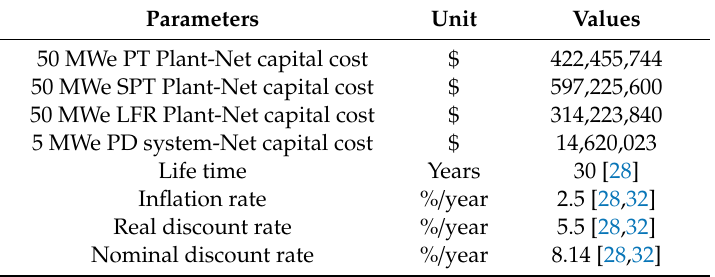
Table 15. Assumptions and data used for economic analysis of the CSP